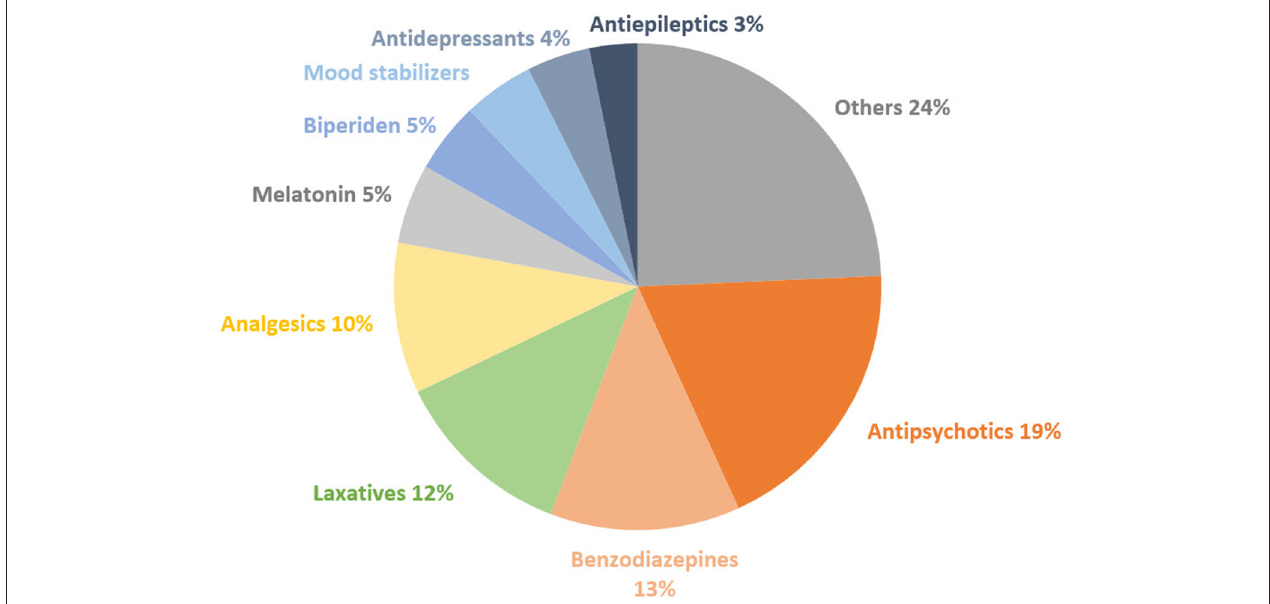
FIGURE 2 | Distribution of the types of drugs on the total number of drugs prescribed to all subjects.